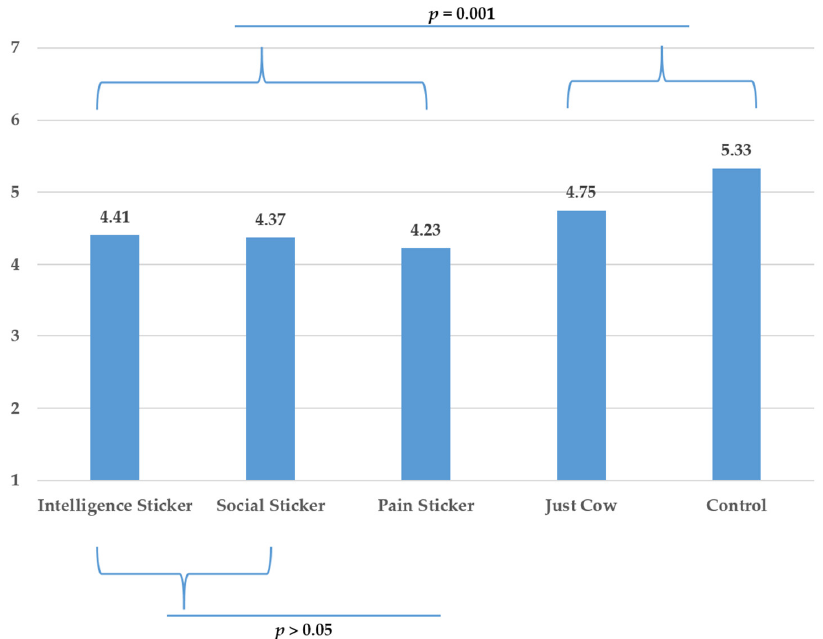
Figure 7. Purchase Intentions: Means for the different conditions and results contrast analyses (Study 2).